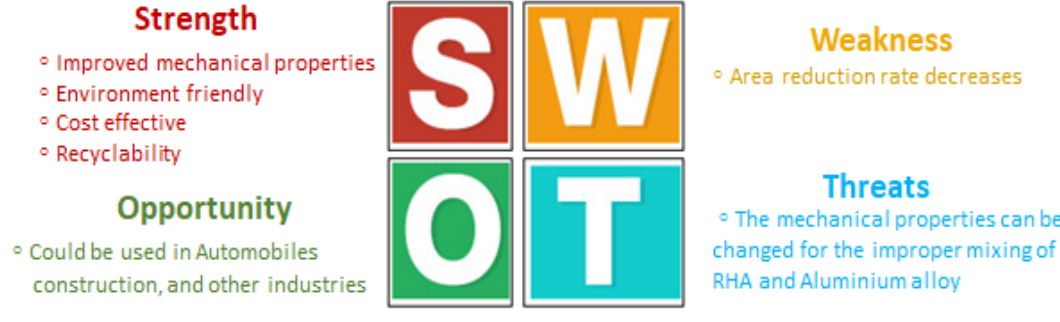
Figure 10: SWOT analysis of aluminium alloy-rice husk ash hybrid